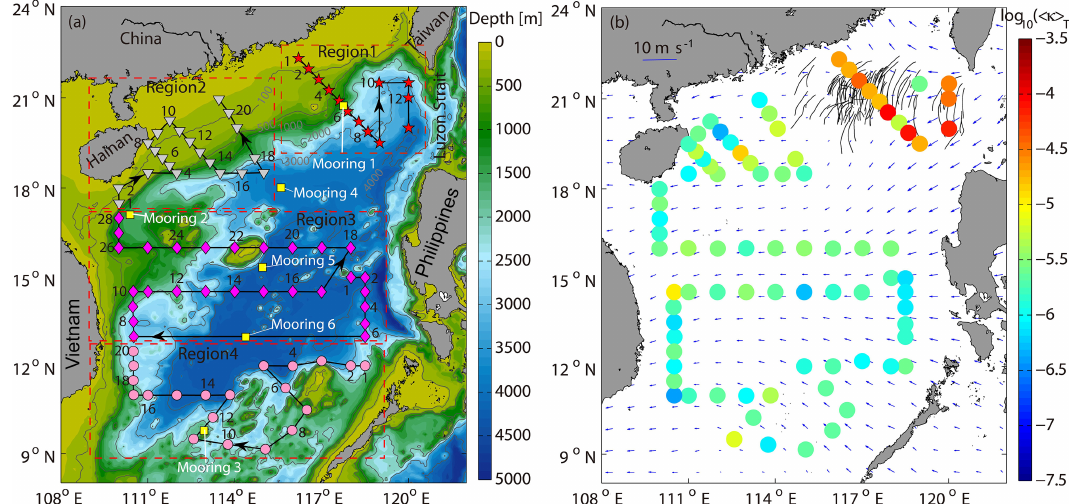
Figure 1. (a) Bottom topography of the SCS and observation stations (symbols). Red stars indicate the stations located in region 1. Gray triangles indicate the stations located in region 2. Magenta diamonds indicate the stations located in region 3. Pink dots indicate the stations located in region 4. Station numbers (i.e., 1, 2, 4 ... ) are indicated in each region. The arrows indicate the order of the measurement. The yellow squares indicate the locations of the moorings. (b) Spatial distribution of (cid:104) κ (cid:105) T (color dots). The blue vector gives the averaged 10m wind speed during the cruises. Black curves in the northern SCS are internal wave packets derived from satellite images by Zhao et al. (2004).